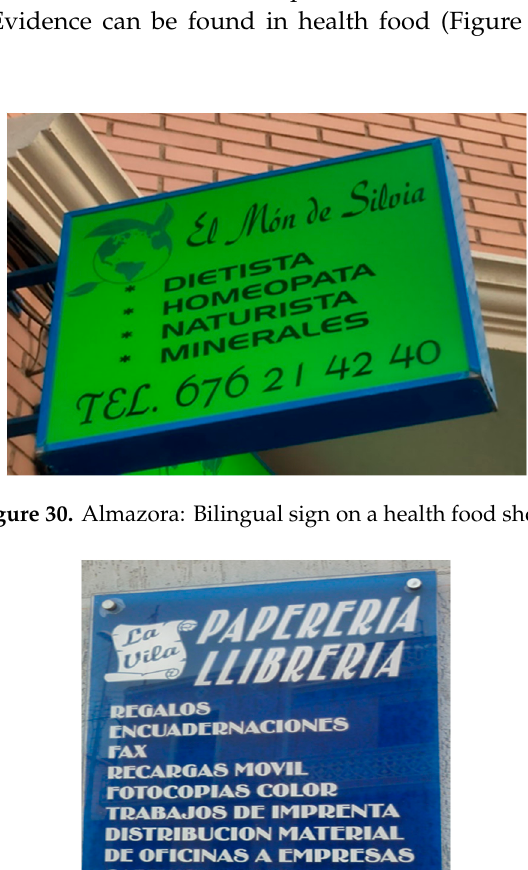
Figure 32. Almazora: English-Valencian sign on a language academy . Figure 33. Almazora: English-Spanish sign on a language academy .